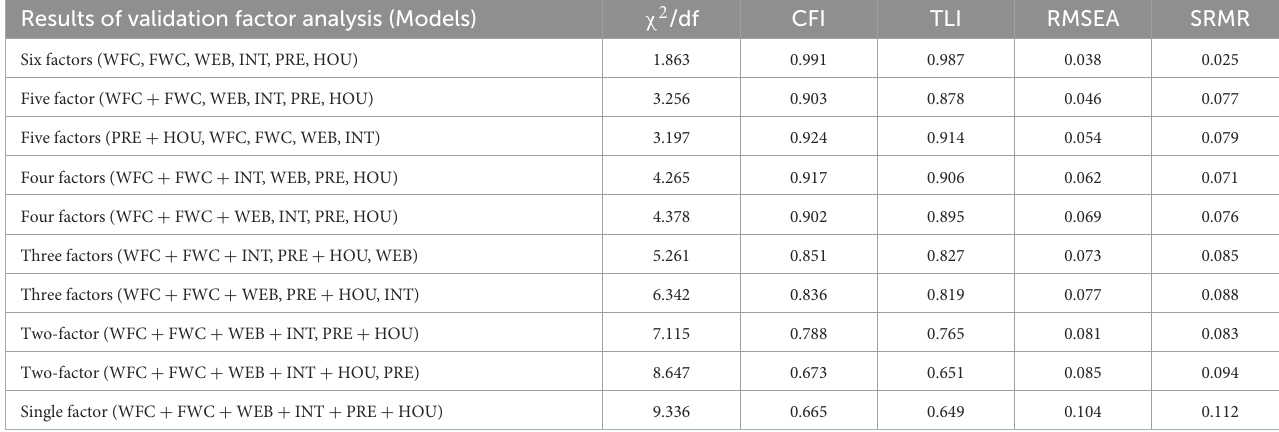
TABLE 1 Results of validation factor analysis. Results of validation factor analysis